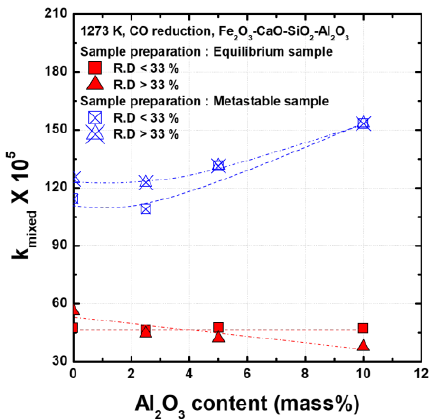
Figure 4. Apparent mixed control rate constants for reduction of Fe 2 O 3 -CaO-SiO 2 -Al 2 O 3 compacts with various Al 2 O 3 contents at 1273 K under CO gas.